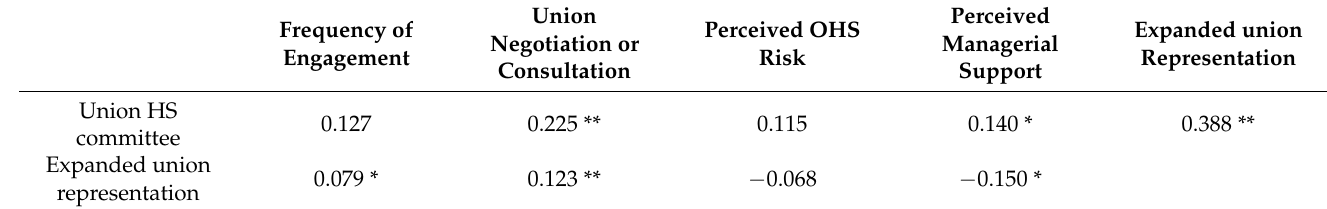
Table 2. Results of Pearson